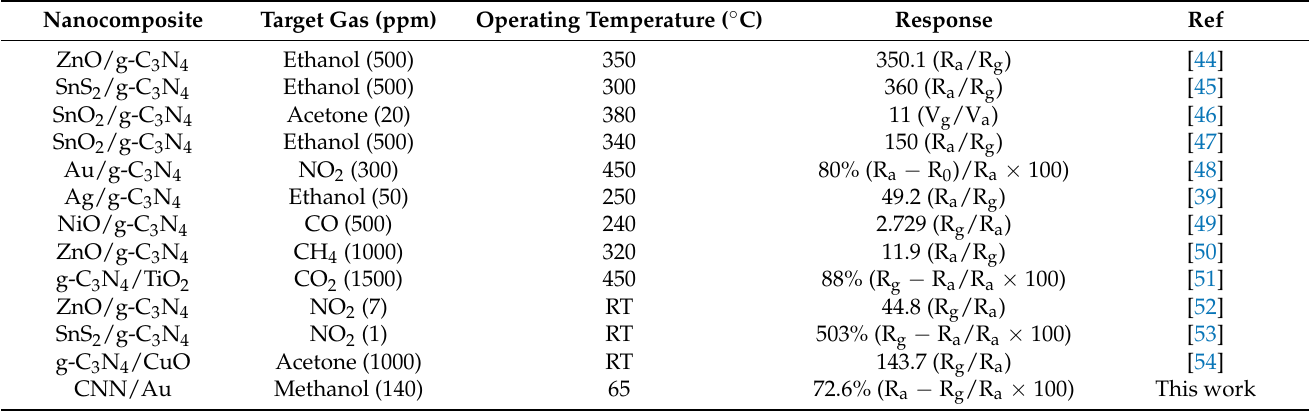
Table 4. Comparison of CNN/Au nanocomposite response with other g-C 3 N 4 -based composites (R 0 is initial resistance before applying steam; R g is the resistance of the material after applying organic vapor; V a and V g are material voltage when applying air and material voltage after application of organic vapor,